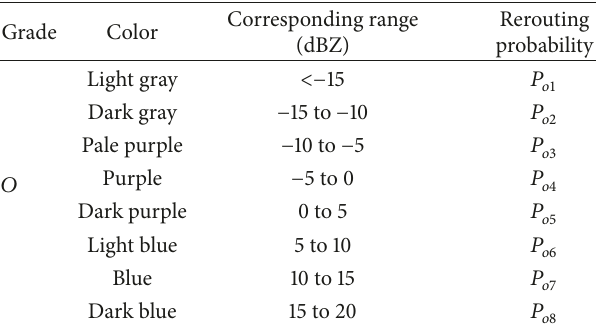
Table 1: Rerouting probabilities when passing the region with O - level precipitation.